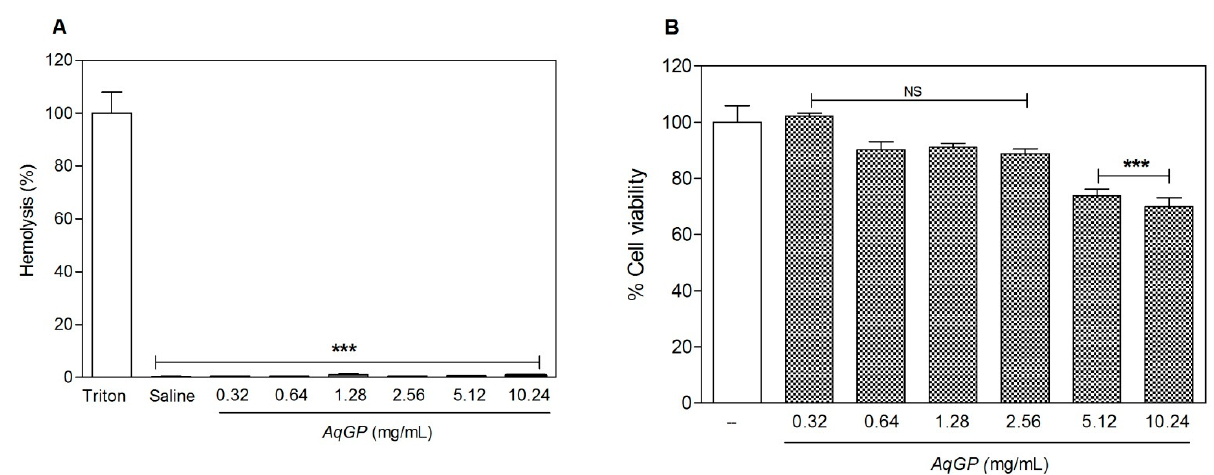
Figure 1. Effects of AqGP in vitro against goat erythrocytes and murine cell line NIH/3T3. ( A ) The hemolytic activity of AqGP on goat erythrocytes was evaluated. ( B ) The effect of AqGP on cell viability of the cell line NIH/3T3 was evaluated by MTT assay. *** p < 0.05 difference as compared to the untreated group, which received only water (ANOVA followed by Bonferroni’s test); NS: not significant.